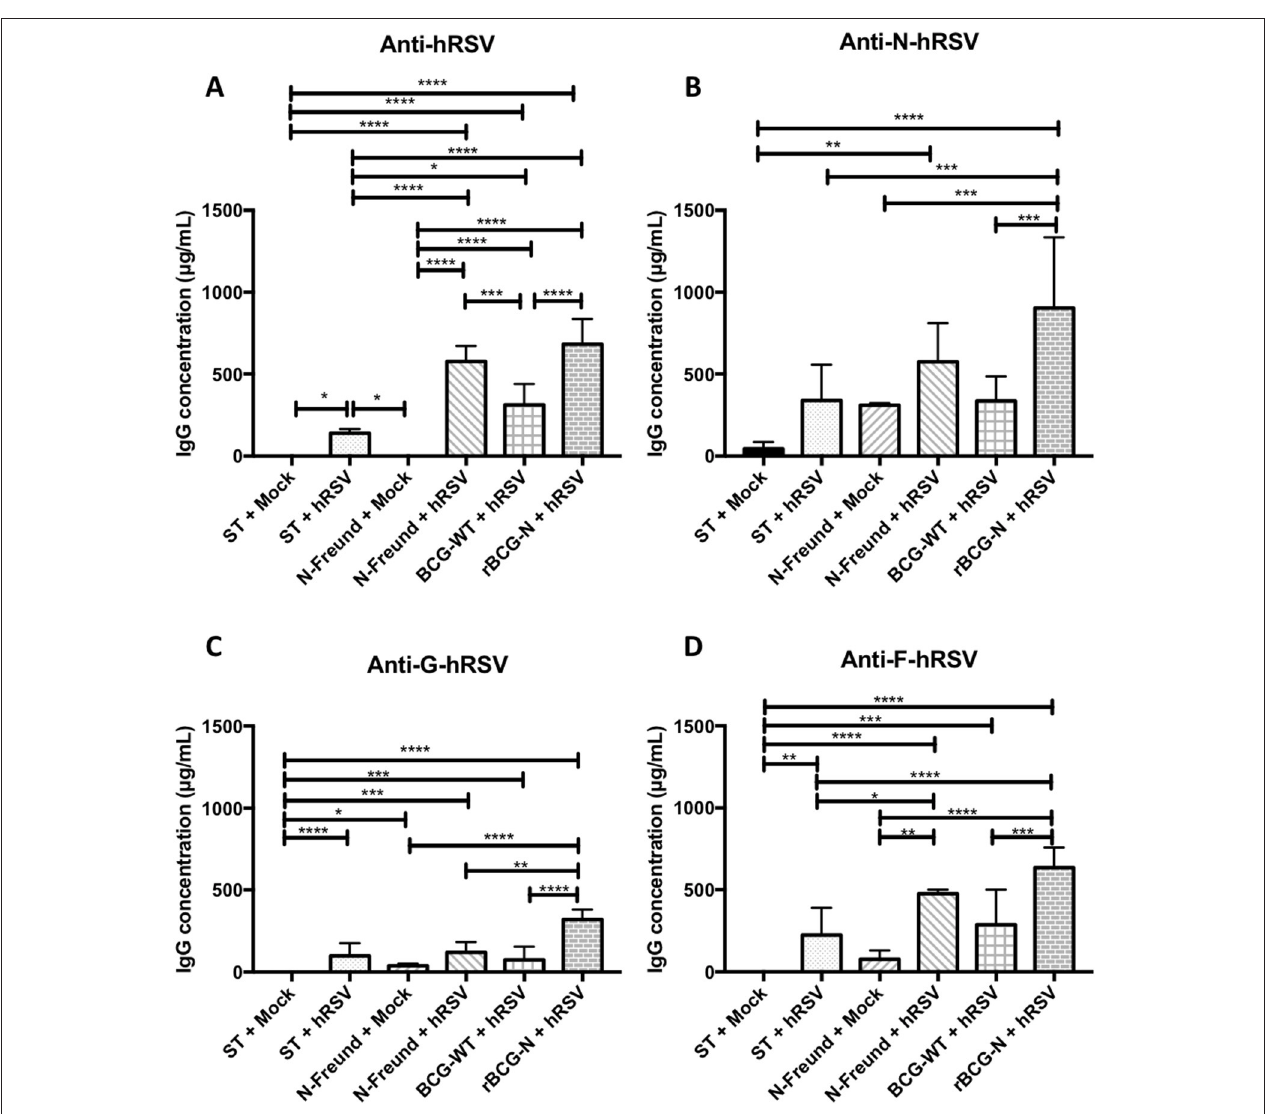
FIGURE 3 | The rBCG-N vaccine promotes the secretion of antibodies against several antigens through the Linked Recognition mechanism . The secretion of specific antibodies against the whole virus and the N, F, and G hRSV proteins were measured by indirect ELISA from the sera collected of the T cell transferred and infected mice after 7 dpi. The anti- hRSV (A) , anti-N-hRSV (B) , anti-F-hRSV (C) and anti-G-hRSV (D) were evaluated and measured at 450nm. The bars observed in the (A–D) are accordingly: Non-transferred and Mock-treated (ST + Mock), Non-transferred, and hRSV-infected (ST + hRSV), T cells transferred from mice immunized with hRSV-N protein in Freund adjuvant, treated with mock (N-Freund + Mock), T cells transferred from mice immunized with hRSV-N protein in Freund adjuvant, infected with hRSV(N-Freund + hRSV), T cells transferred from mice immunized with BCG-WT and then infected with hRSV (BCG-WT + hRSV) and T cells transferred from mice immunized with rBCG-N and then infected with hRSV (rBCG-N + hRSV). The sera from five different animals for each group was used for the ELISA assay, with each serum tested in three replicates. Data combinate from two independent experiment for ST + mock, ST + hRSV, BGC-WT + hRSV and rBCG-N + hRSV groups ( N = 9), and one independent experiment for N-Freund + Mock, N-Freund + hRSV groups ( N = 5). Differences were evaluated by a one-way ANOVA (* p < 0.05; ** p < 0.01; *** p ≤ 0.001; **** p ≤ 0.0001). The error bars represent the Standard Deviation